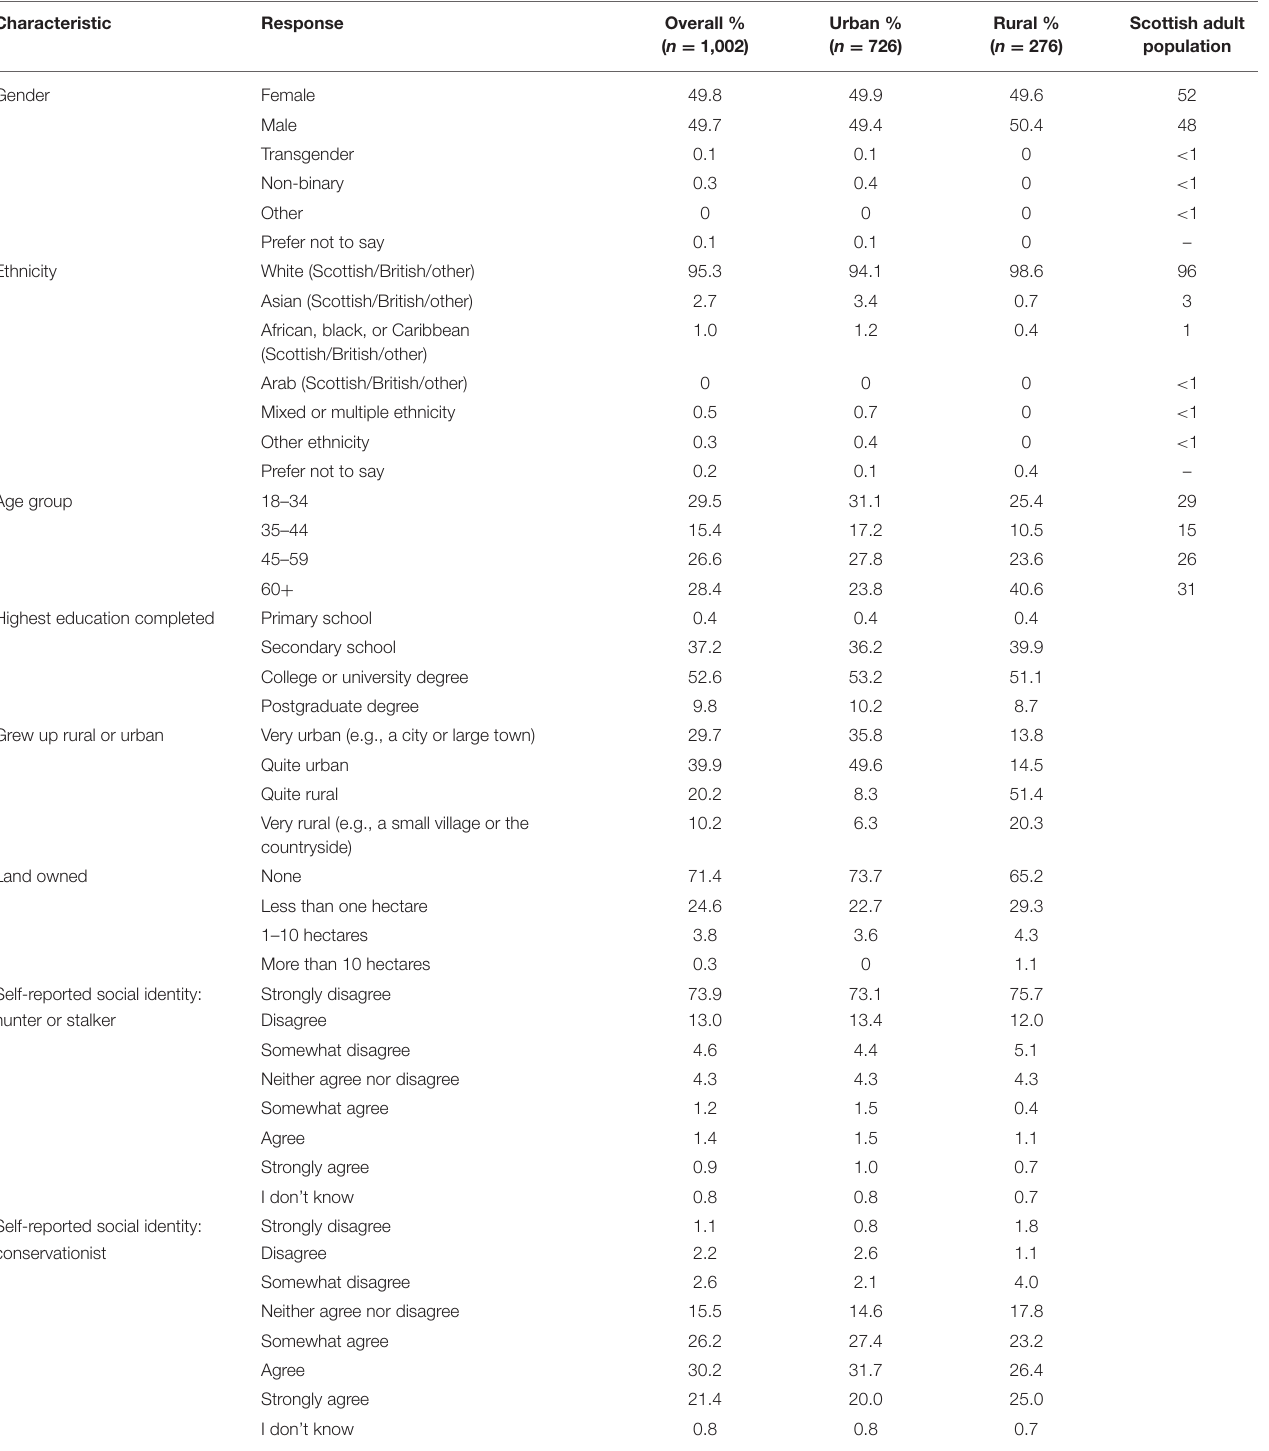
TABLE 1 | Descriptive statistics for overall sample and split by rural and urban respondents.